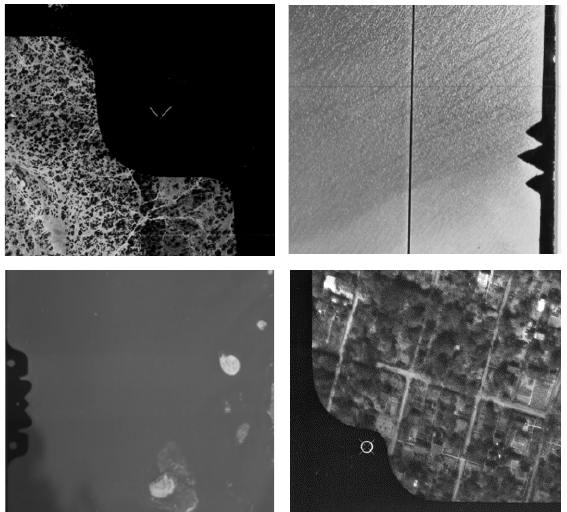
Figure 3. Examples of different types of fiducial marks visible, or partially visible, in the TIME archival